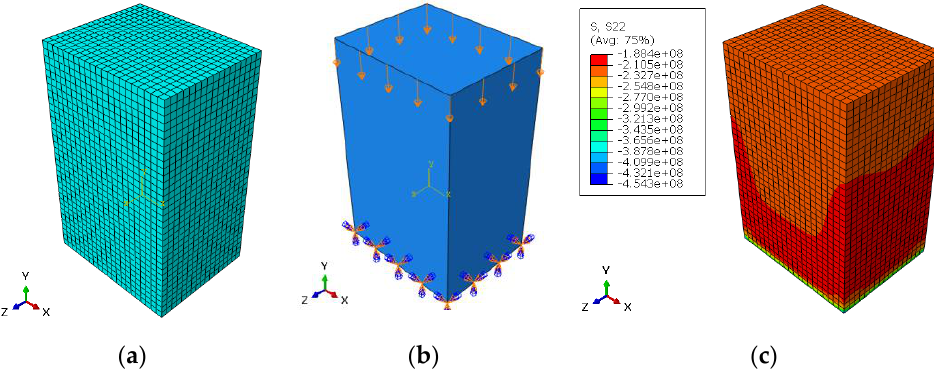
Figure 8. ( a ) FE model, ( b ) boundary conditions and ( c ) stress distribution for axial direction. For tangential direction, the dimensions of the selected sample in the three directions were: 8.9 × 9.83 × 11.45 mm when the experimental fracture stress was 96.01 MPa (see Table 3). The mesh model contained 15,950 elements when the element type was C3D20R (20-node quadratic brick). The number of nodes was: 69,692. The convergence study for element numbers gives less than 1% with element size = 0.0004 m. For the boundary conditions, the displacement in z-direction was: 0.000578 m in compression and the front surface in x–y plane was prevented from movement and rotation in x, y and z